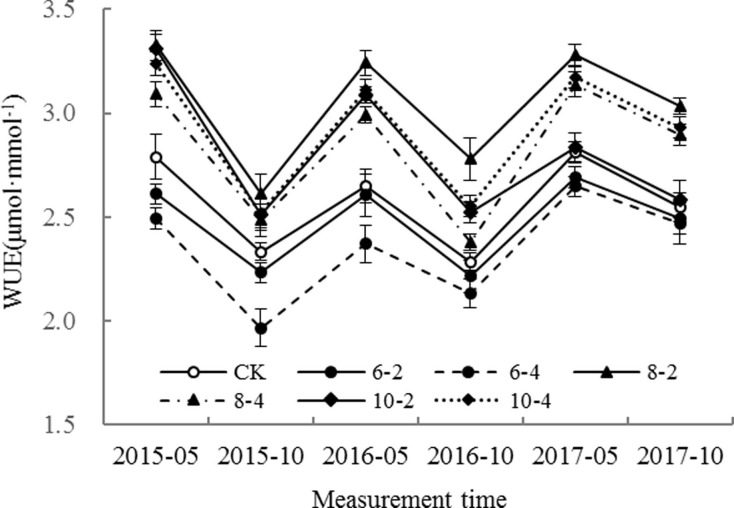
Effects of root pruning on WUE of poplar leaves.Bars are means and error bars are standard deviations (n = 3).